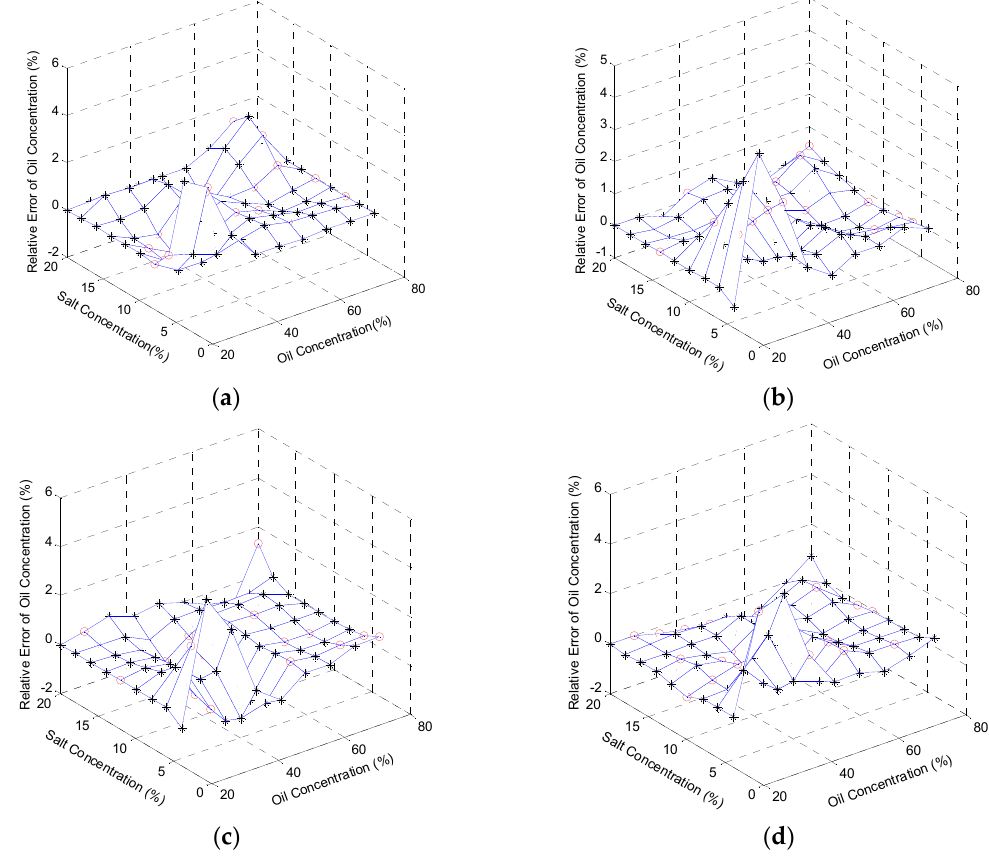
Figure 7. Relative errors of reconstructed oil concentrations at: ( a ) 5 °C; ( b ) 15 °C; ( c ) 25 °C; and ( d ) 35 °C. Black stars (*) stand for the relative errors of the training data, and red circles (o) represent those